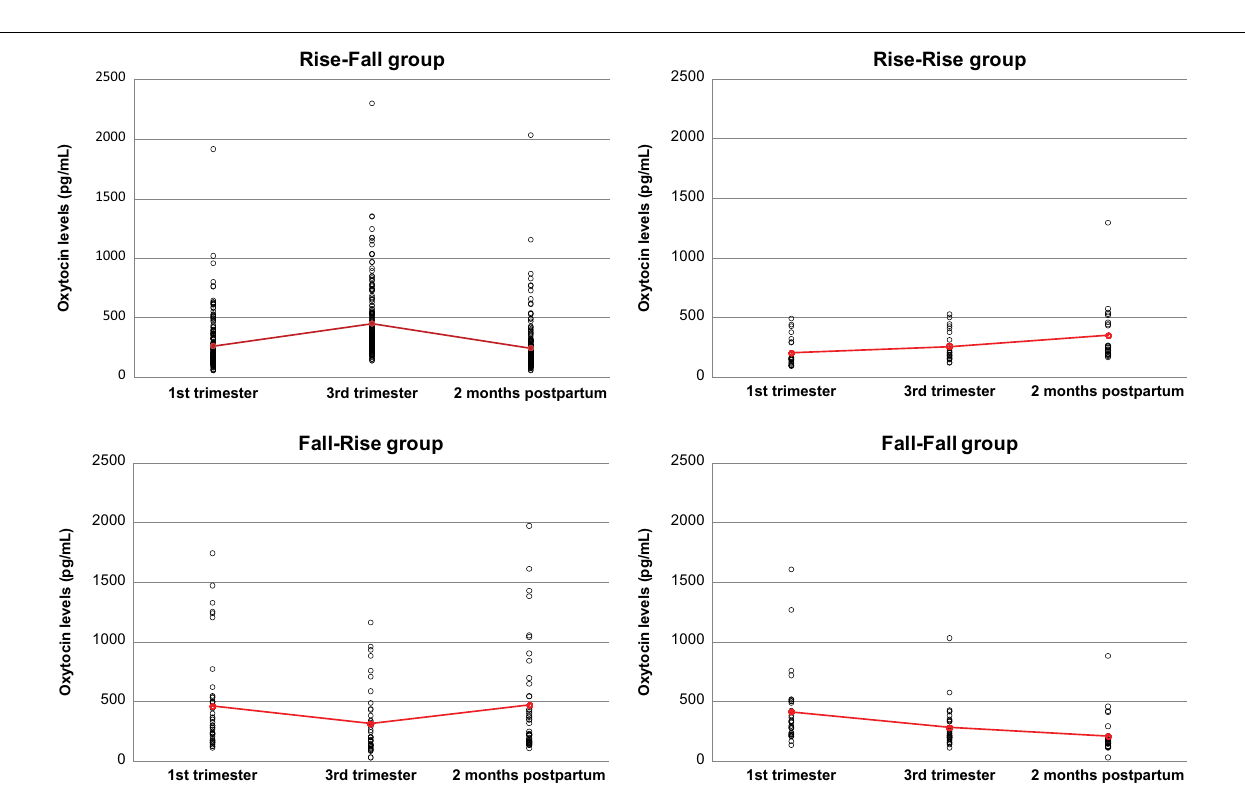
FIGURE 2 | Plasma oxytocin levels in the four groups of women with different patterns of oxytocin level variations . Red crosses indicate mean values for each time